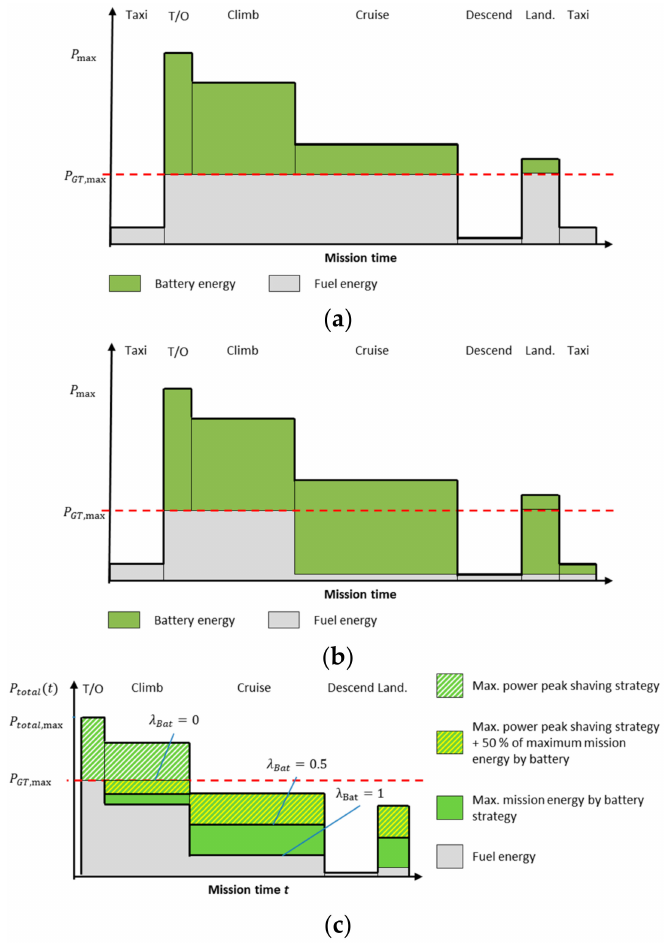
Figure 2. Definitionofbatteryoperation: ( a )maximumpowerpeakshavingstrategy; ( b )providingmaximum battery energy depending on electric motor power sizing; ( c ) battery strategy parameter